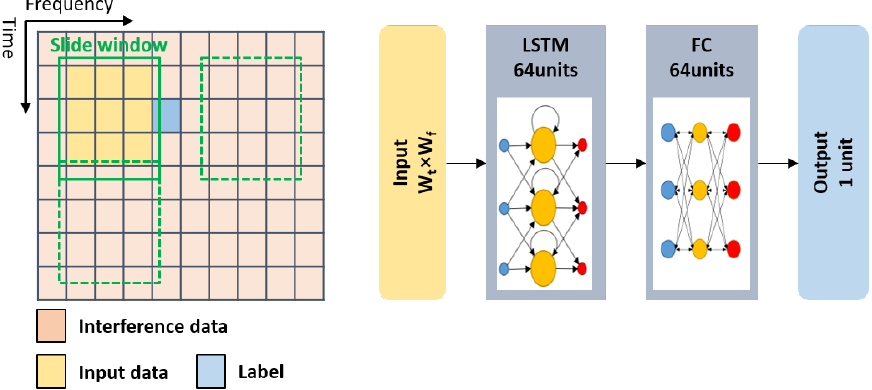
Figure 3. The slide window used in the dataset generation (e.g., W t = 3 and W f = 3) and the LSTM prediction network